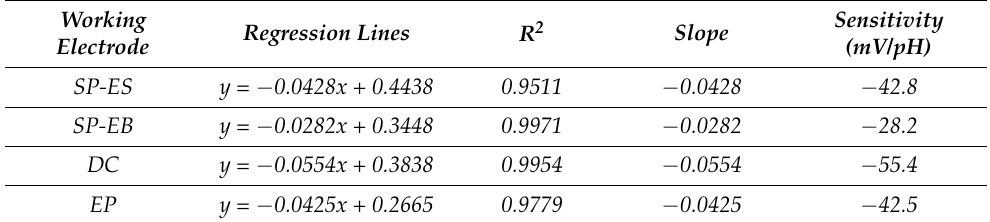
Table 2. Curve-fitting, linearity, and sensitivity data corresponding to Figure 12c.